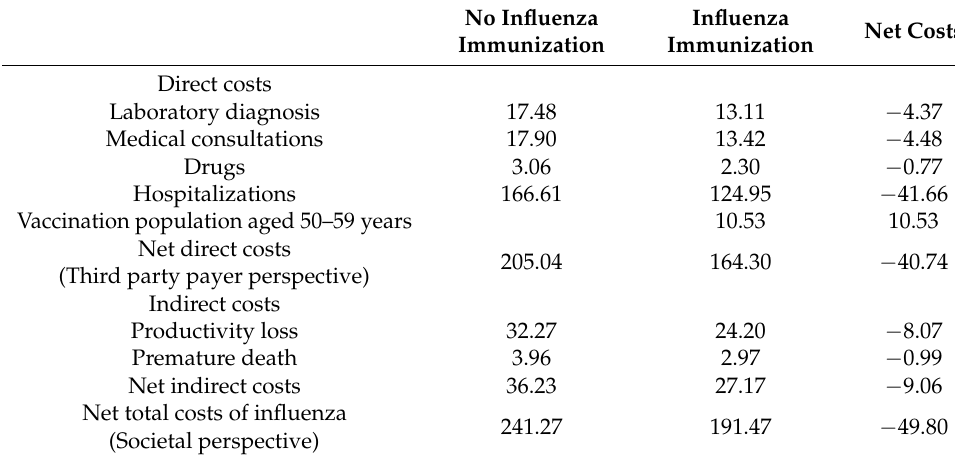
Table 9. Costs averted (million US dollars).